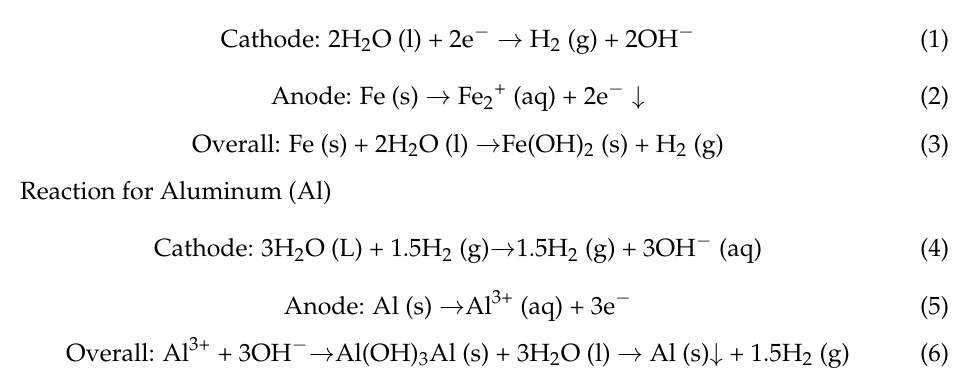
Figure 2. Diagram of the lab-scale EC reactor: (1) glass beaker (reactor), (2) cathode-1, (3) cathode-2, (4) anode-1, (5) anode-2, (6) positive wire, (7) negative wire, (8) dc power supply, (9) air pump, (10) air tube, (11) air stone, (12) magnetic bar, (13) magnetic stirrer, and (14) supporting stands. Reaction for Iron (Fe )